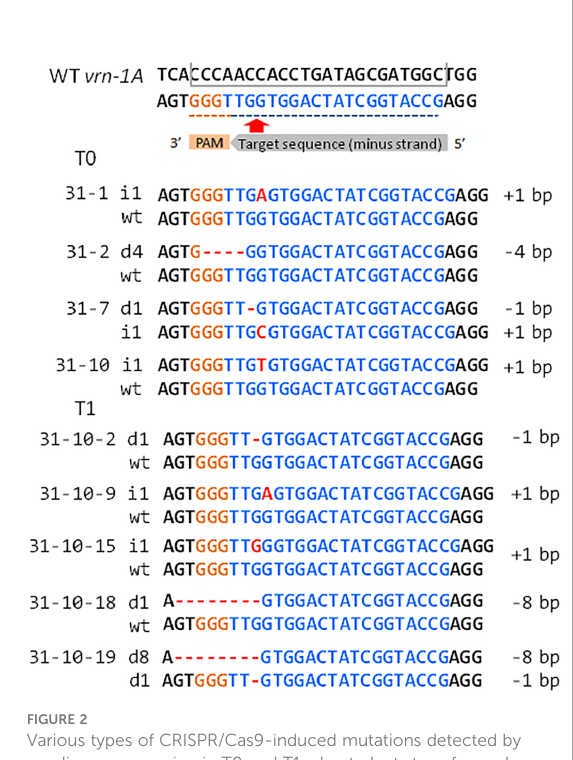
FIGURE 2 Various types of CRISPR/Cas9-induced mutations detected by amplicon sequencing in T0 and T1 wheat plants transformed with pgRNA-VRNA1#31. Bases in the black rectangle represent the target sequence vr-31,orangebases indicate the protospacer adjacent motif (PAM),andblue bases show the guide RNA- associated region, with sequences inred corresponding to insertion or deletionof